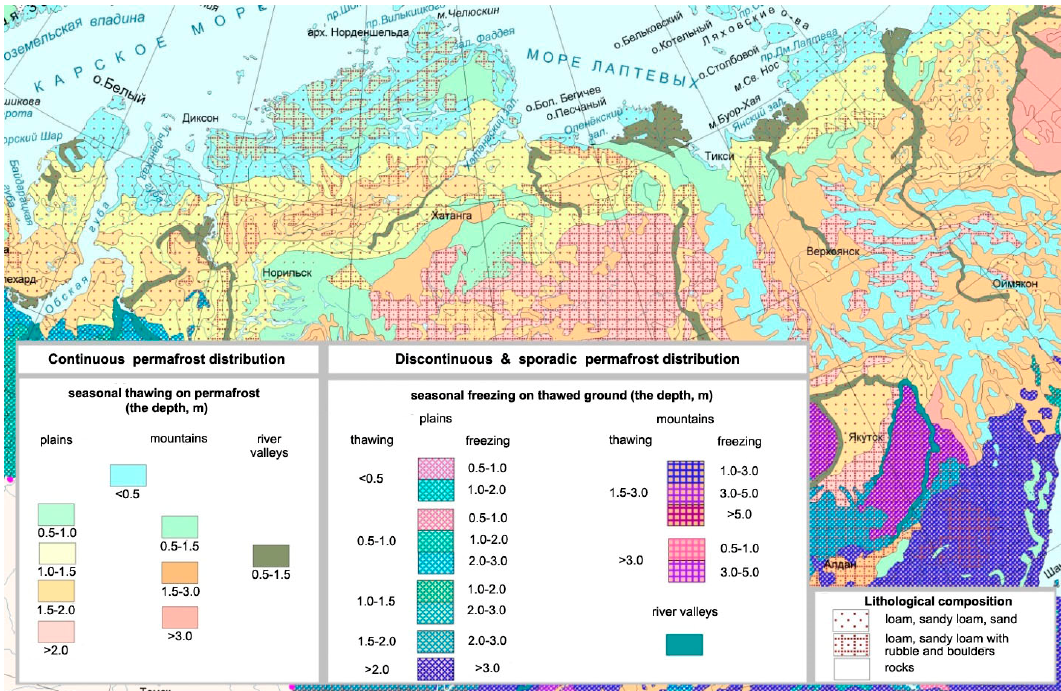
Figure 8. Legend and map fragment of Seasonal Freezing and Thawing map.